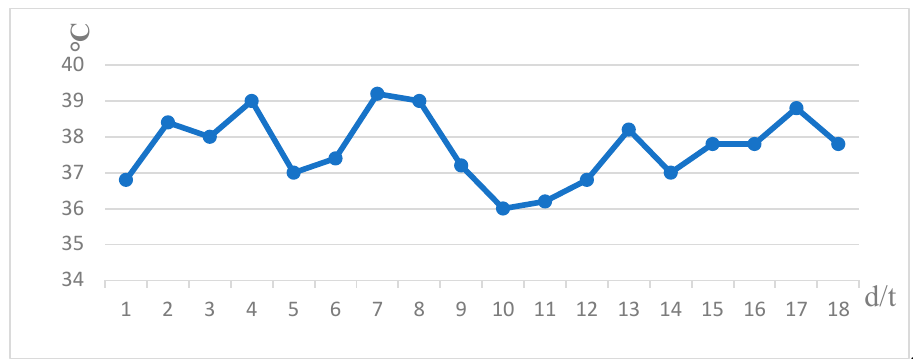
Figure 2. After admission to the hospital, the patient’s body temperature slowly increased.